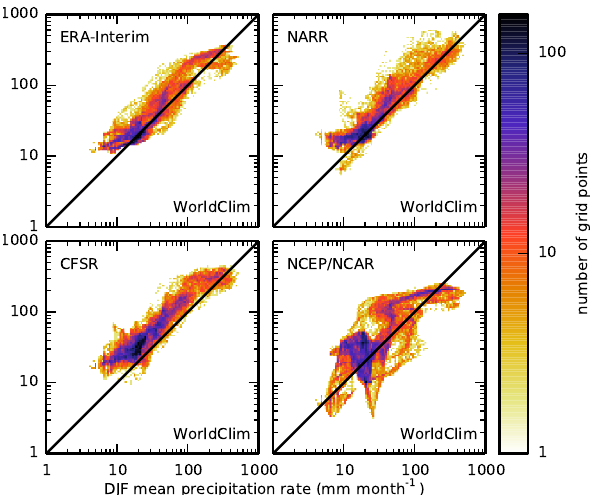
Figure 10. Density maps showing a comparison of winter (DJF) precipitation rate from the WorldClim climatology, against that of each reanalysis, after bilinear spatial interpolation. Colour mapping is based on a logarithmic scale. Note the wet bias of all reanalysis data relative to WorldClim data.